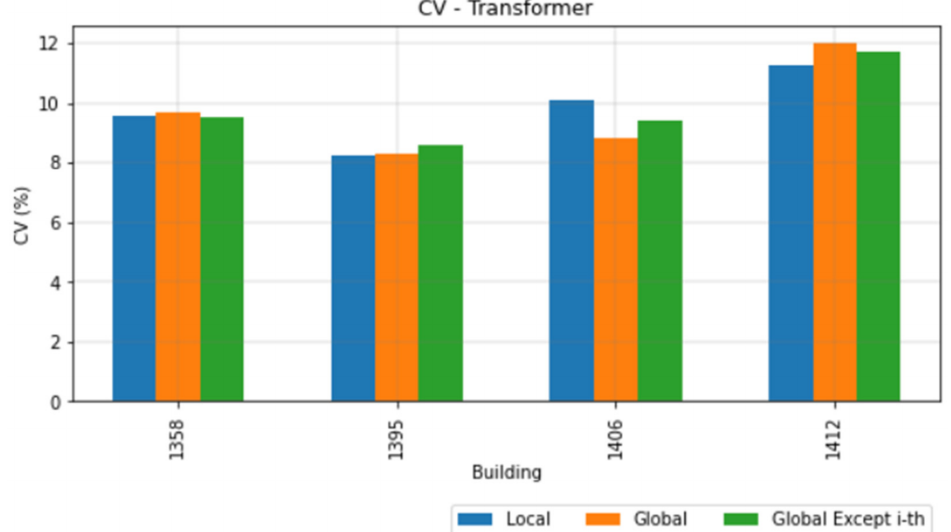
Figure 23. Comparison between the CV on test set obtained using Transformer method with different modalities: local, global and global trained using all the available data except the energy consumption related to the selected